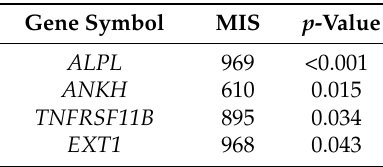
Table 5. Information on important disease genes of